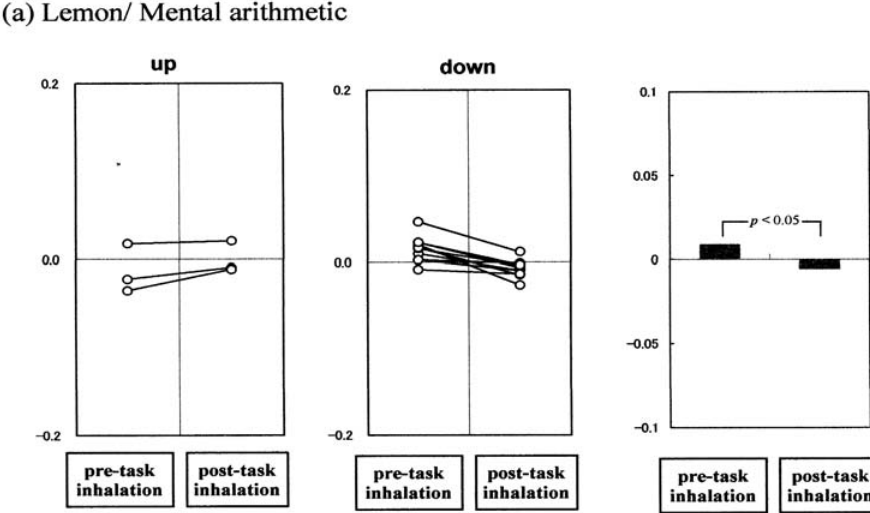
Figure 7. Skin temperature changes following inhalation of lemon as a function of behavioural task. The net intensity change in skin temperature (see text) was calculated between pre- and post-task inhalations with respect to presentation of the odourless blank and the target fragrance in each trial. In line segment graph, these are connected by a solid line for each subject in each experimental run and the cases showing upward skin temperature changes after the task are plotted on the left, while those with a downward tendency are represented in the middle panels. The summarized mean values of net intensity changes obtained from pre and post task inhalations are depicted respectively as bar graph on the right. ( a ) The number of subjects was 18 as for lemon/mental arithmetic; and ( b ) was 20 as with lemon/auditory